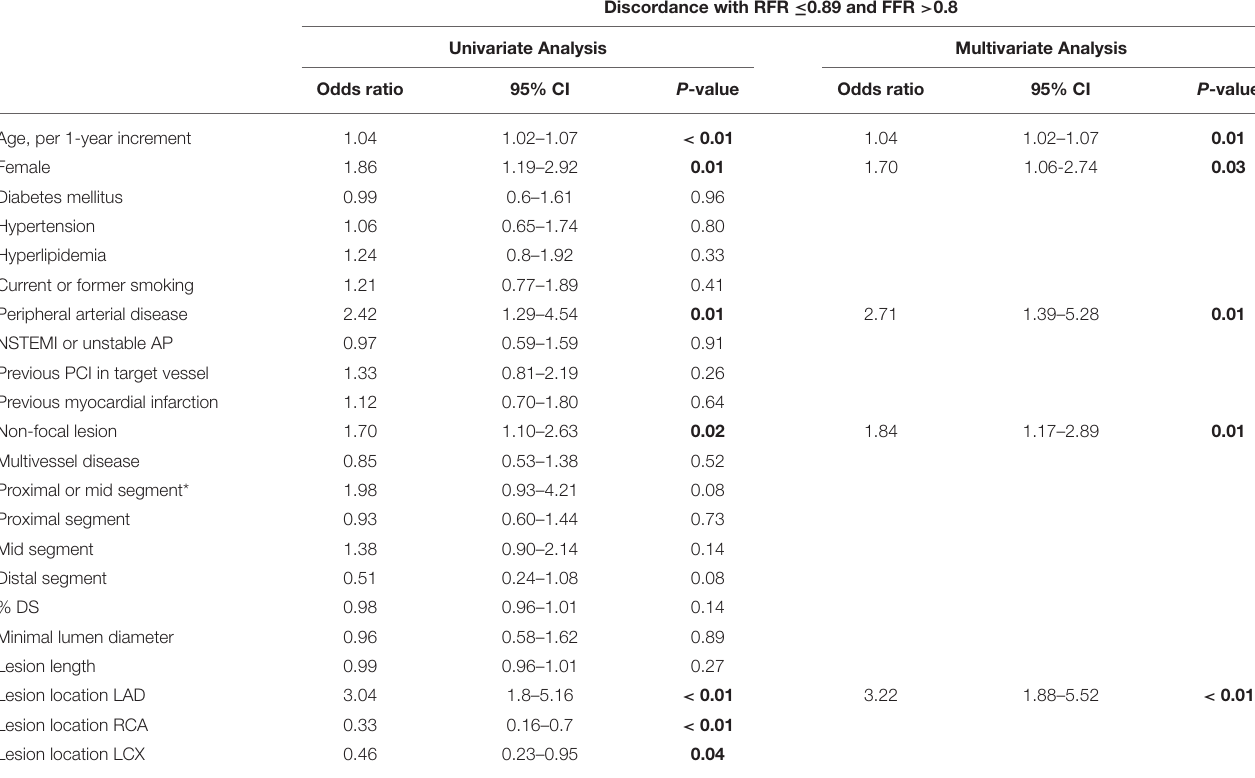
Discordance with RFR ≤ 0.89 and FFR >